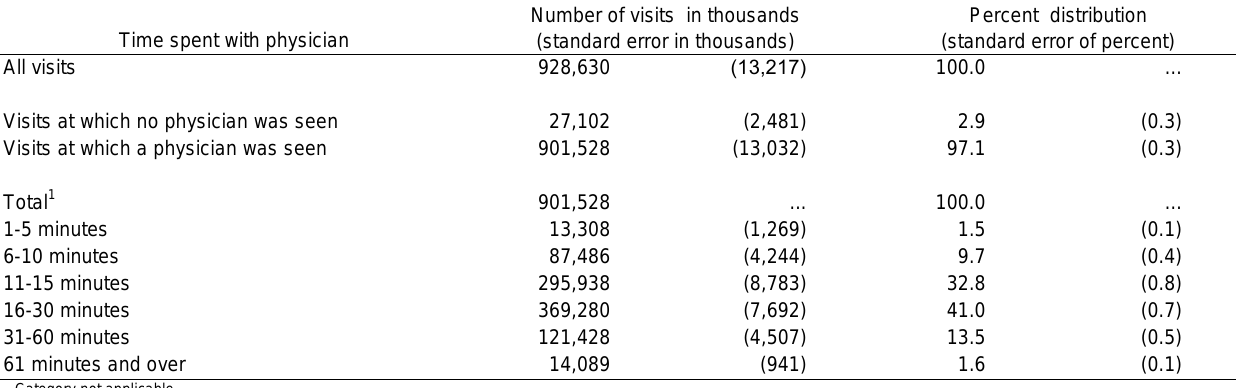
Table 29. Time spent with physician: United States, 2012